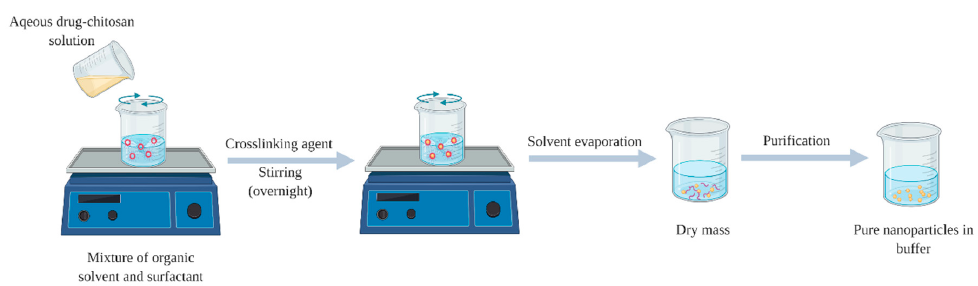
Figure 6. Schematic diagram of chitosan nanoparticles prepared via reverse micellar method.